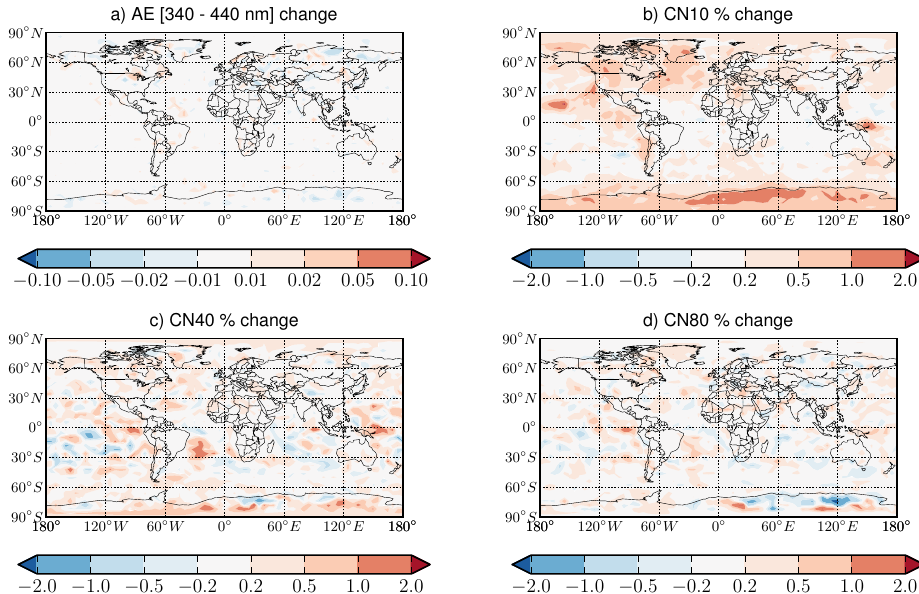
Fig. 7. Percentage change between solar-minimum and solar-maximum BASE simulations of the ˚Angstrom Exponent and surface CN10, CN40 and CN80 concentrations. Higher values (red) indicate higher AE or more particles in the solar-minimum (0.4GV modulating poten- tial)